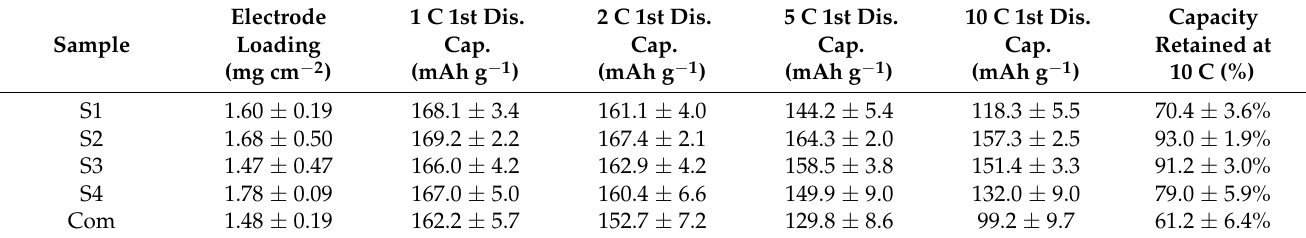
Table 3. Results of high-rate chronopotentiometry sol–gel synthesized LTO and commercial